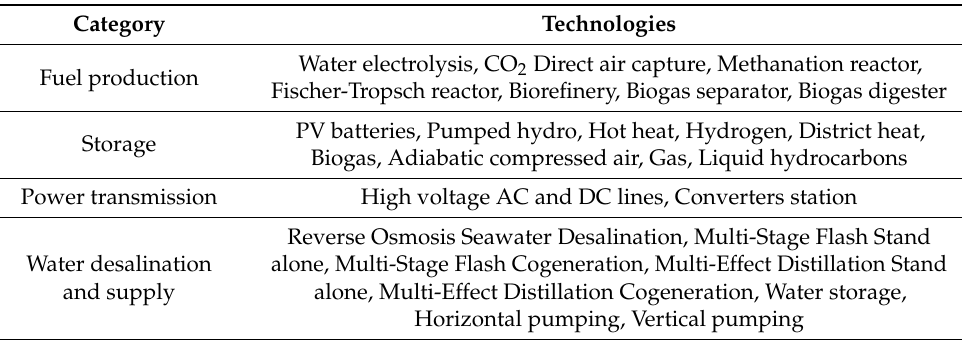
Table 4. Fuel production, storage, power transmission, and water desalination and supply technolo- gies (adapted from